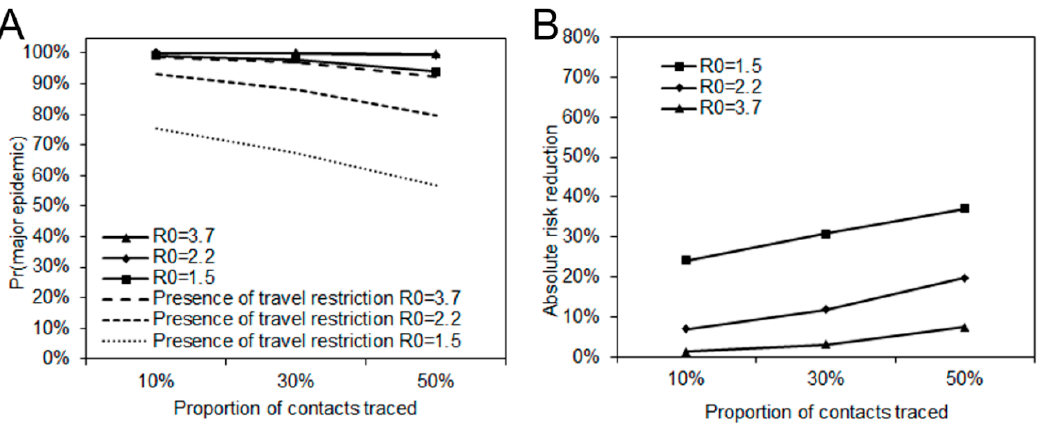
Figure 3. Probability of a major epidemic with various levels of transmissibility and traced contact. ( A ) The solid lines represent the probability of a major epidemic in the counterfactual scenario, i.e., based on the expected number of cases diagnosed in Japan. Dashed lines represent the probability of a major epidemic in the presence of travel volume reductions, calculated using the number of traced and untraced cases was 6 in total in Japan from Day 58 to Day 67. Contact tracing leading to isolation was assumed at three different levels: 10%, 30%, and 50%. ( B ) The vertical axis represents the reduced probability of a major epidemic due to travel volume reduction. The horizontal axis shows the proportion of cases traced, adopting the same scenarios as panel A.